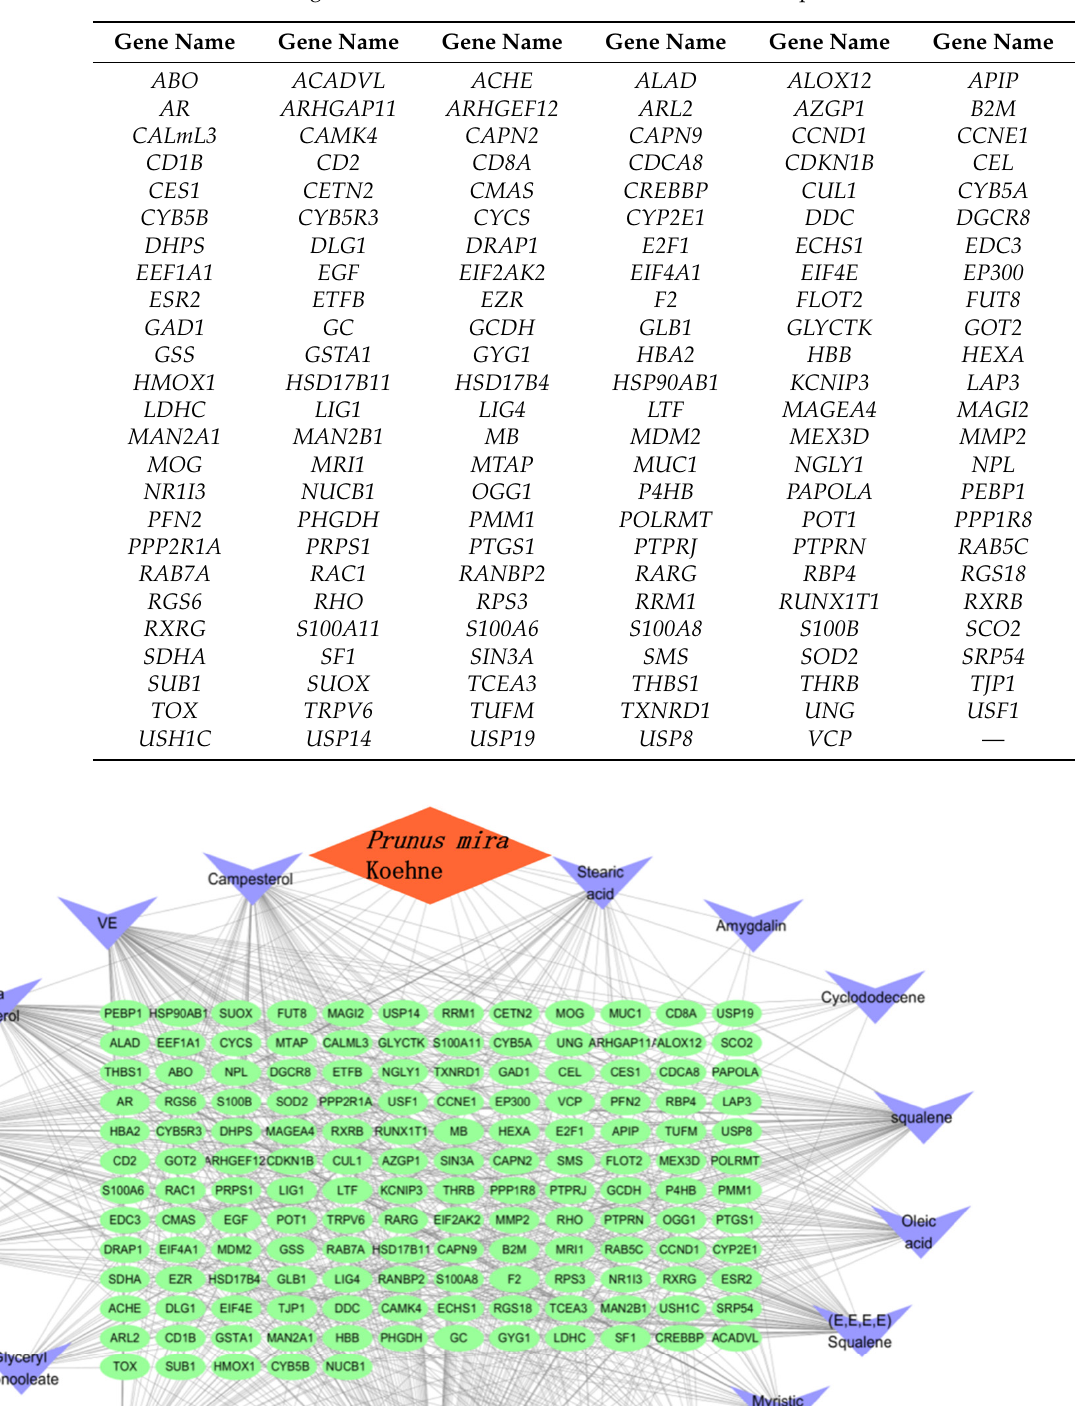
Table 10. Potential targets of the kernel of P. mira in the treatment of alopecia.